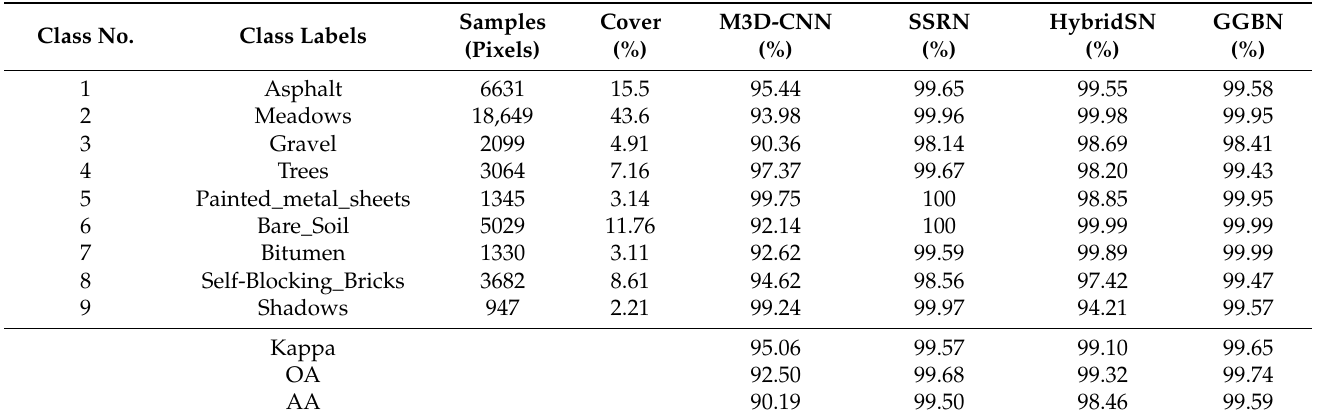
Table 3. Classification Results (%) of UP Dataset.